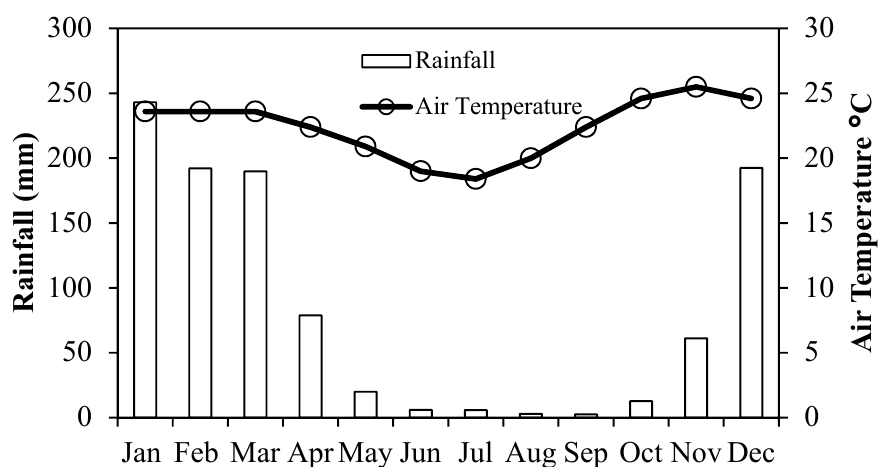
Figure 2. Monthly mean temperature and rainfall in Malawi (1991–2015). There are three seasons: the cool dry season (May–August), hot dry season (September–October), and warm wet season (November–April). Data source: [24].